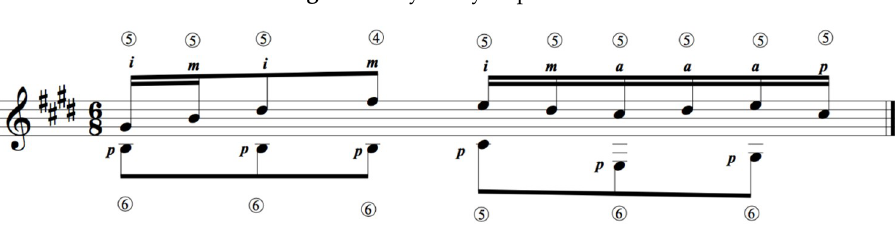
Figure 4. Physically Impossible.